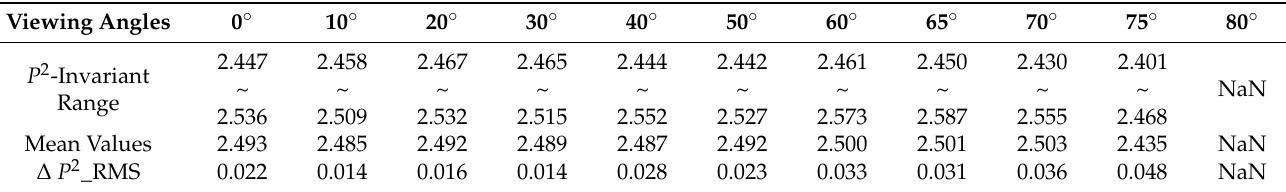
Table 7. The range and precision of P 2 -invariant.